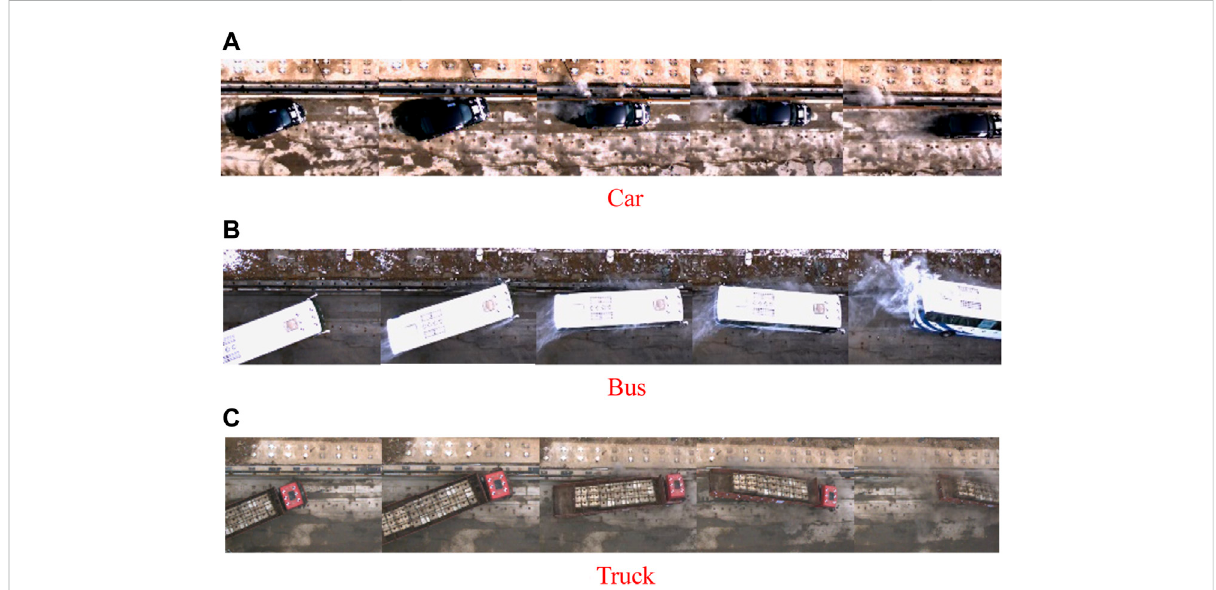
FIGURE 5 Schematic diagram of the driving process of the car, bus, and truck (left to right). (A) Car. (B) Bus. (C) Truck.